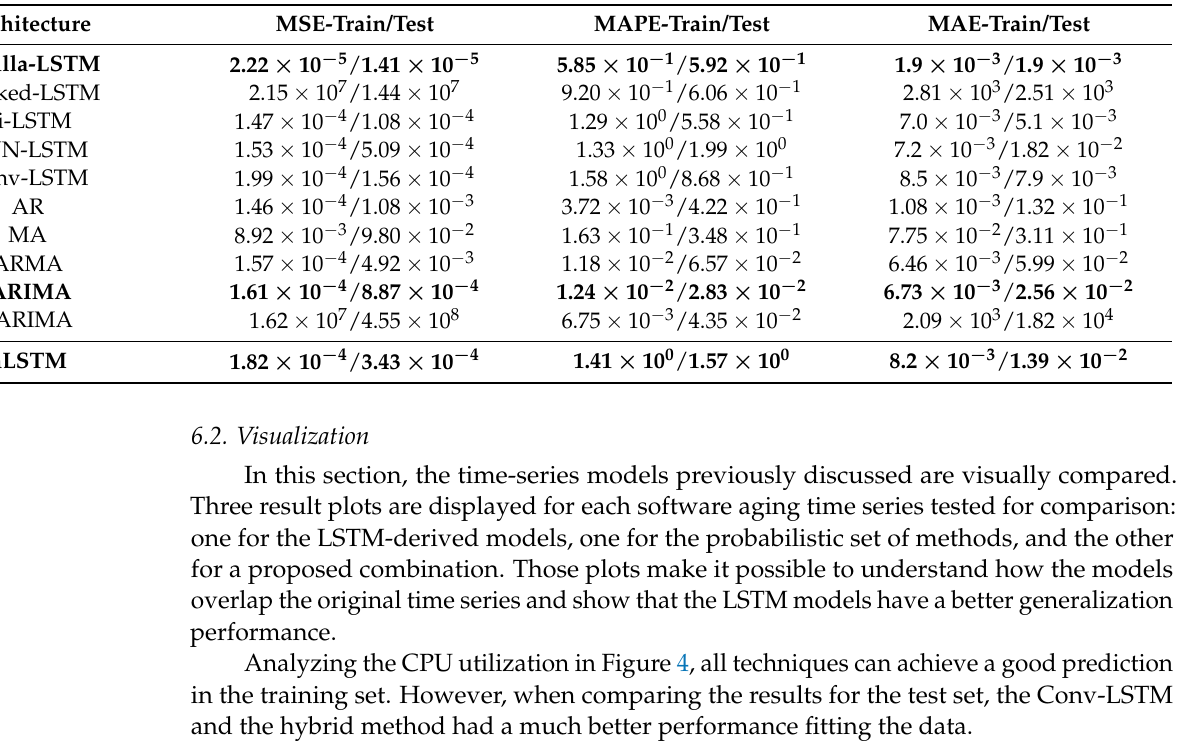
Table 5. Results of evaluation metrics for memory used with five virtual